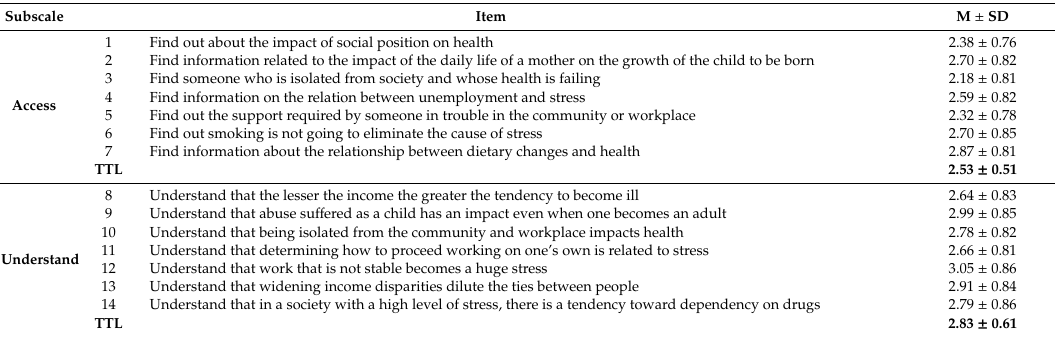
Table 2. Level of HL-SDH among Workers ( N =